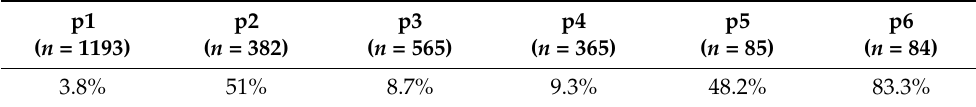
Table 5. Grabbing ratio in the descent